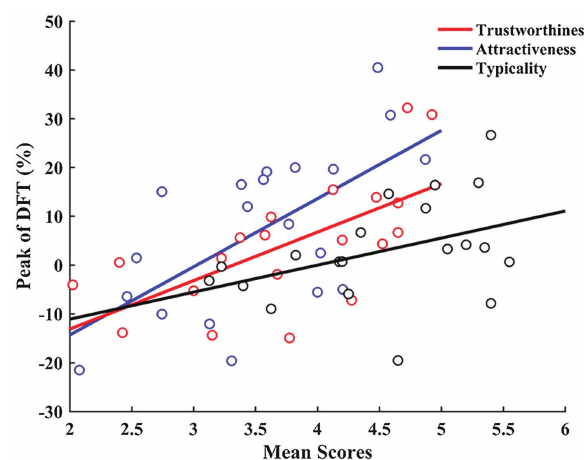
FIGURE 5 | Relationships between mean trait ratings of original faces and the predicted DFT for peaks of mean trait judgments in corresponding continua. Lines represent best linear fits for trustworthiness (red), attractiveness (blue), and typicality (black) data.